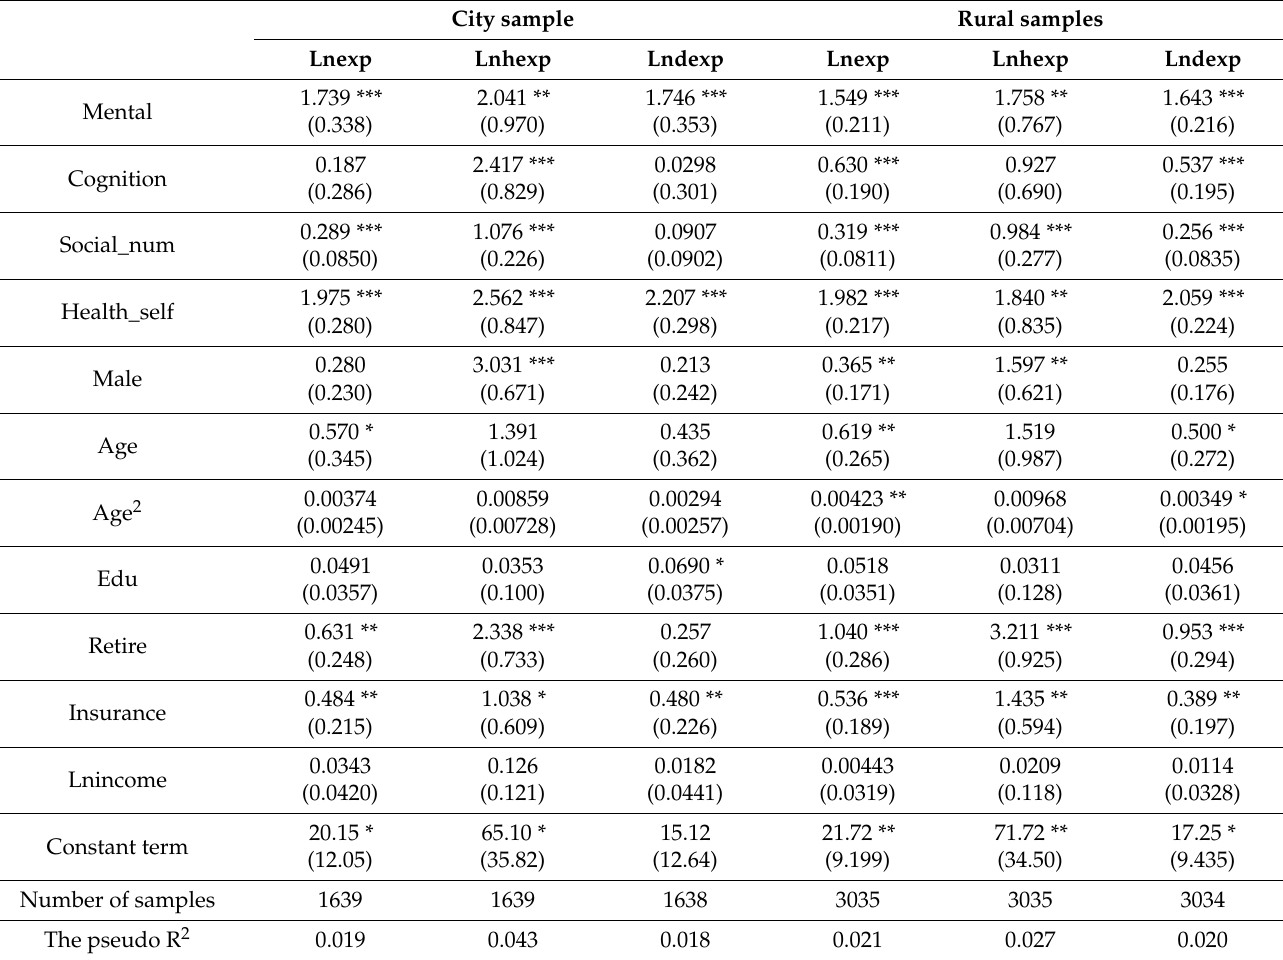
Table 10. Urban-rural differences in health